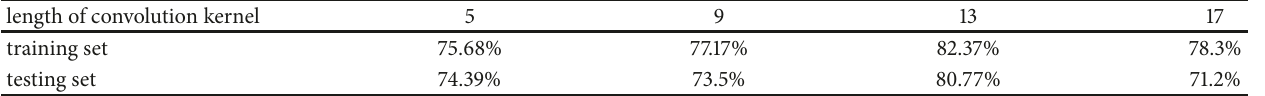
Table 1: Classification rates of CNN under different lengths of the convolution kernel.